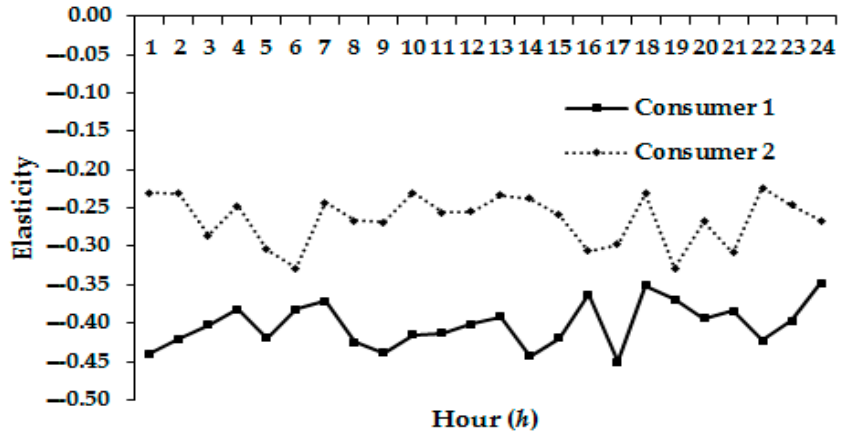
Figure 10. Daily price elasticity curves using the linear model.